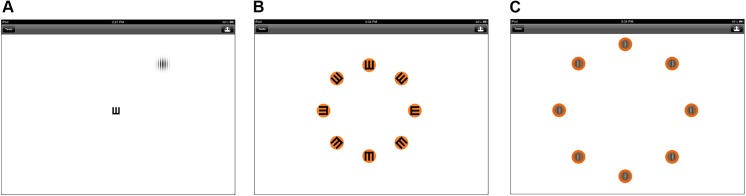
Screen shots taken during the PERformance CEntered Portable Test used for assessment of visual performance in glaucoma and control subjects.(A) Simultaneous presentation of the central and peripheral stimuli. (B) Response screen. The subject had to identify the orientation of the centrally presented “tumbling E”. (C) Response screen. The subject had to identify the location of the peripheral stimulus.